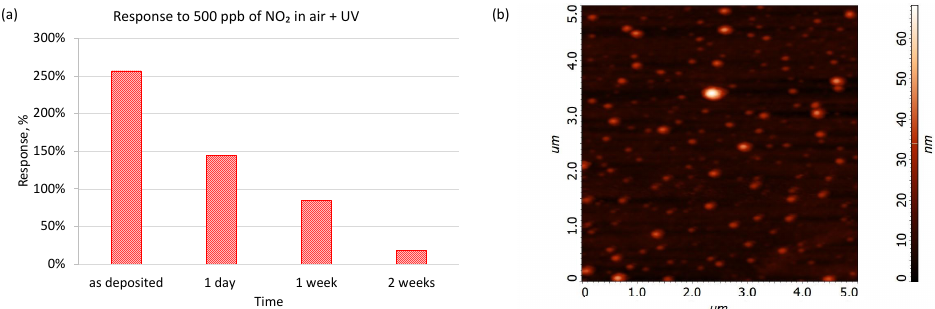
Figure 10. ( a ) Response of SilPEG to 500 ppb of NO 2 in air under long-term continuous UV illumina- tion; ( b ) AFM image of SilPEG after two weeks aging under UV in